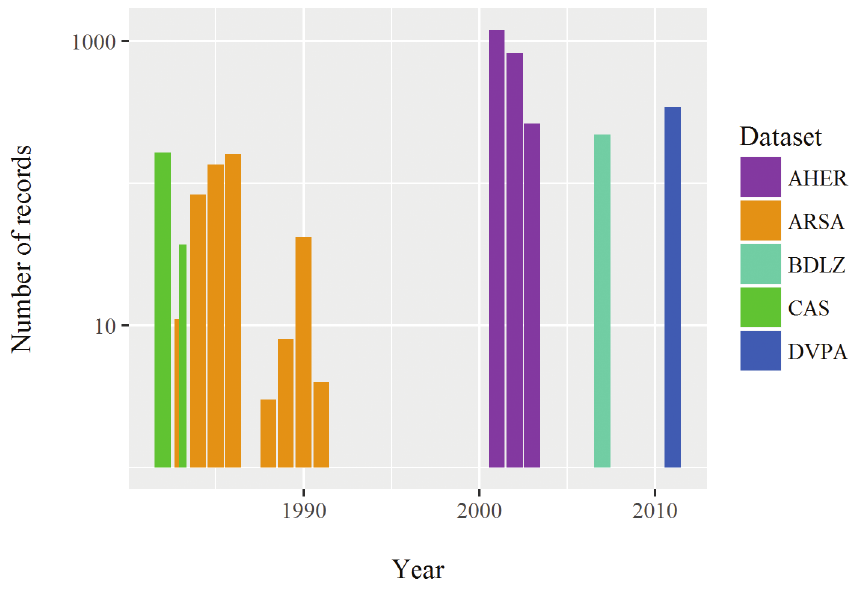
Figure 3. Temporal distribution of the records by dataset. Number of records in log